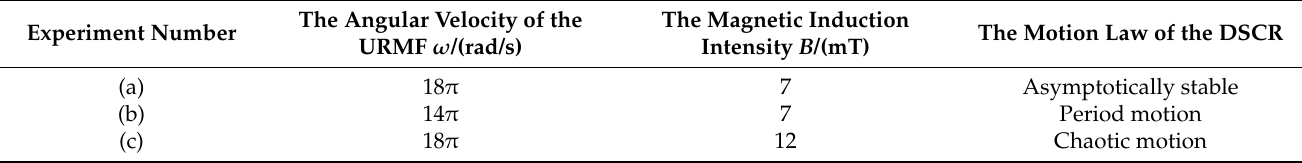
Table 3. The cross experiments of the posture stability of the